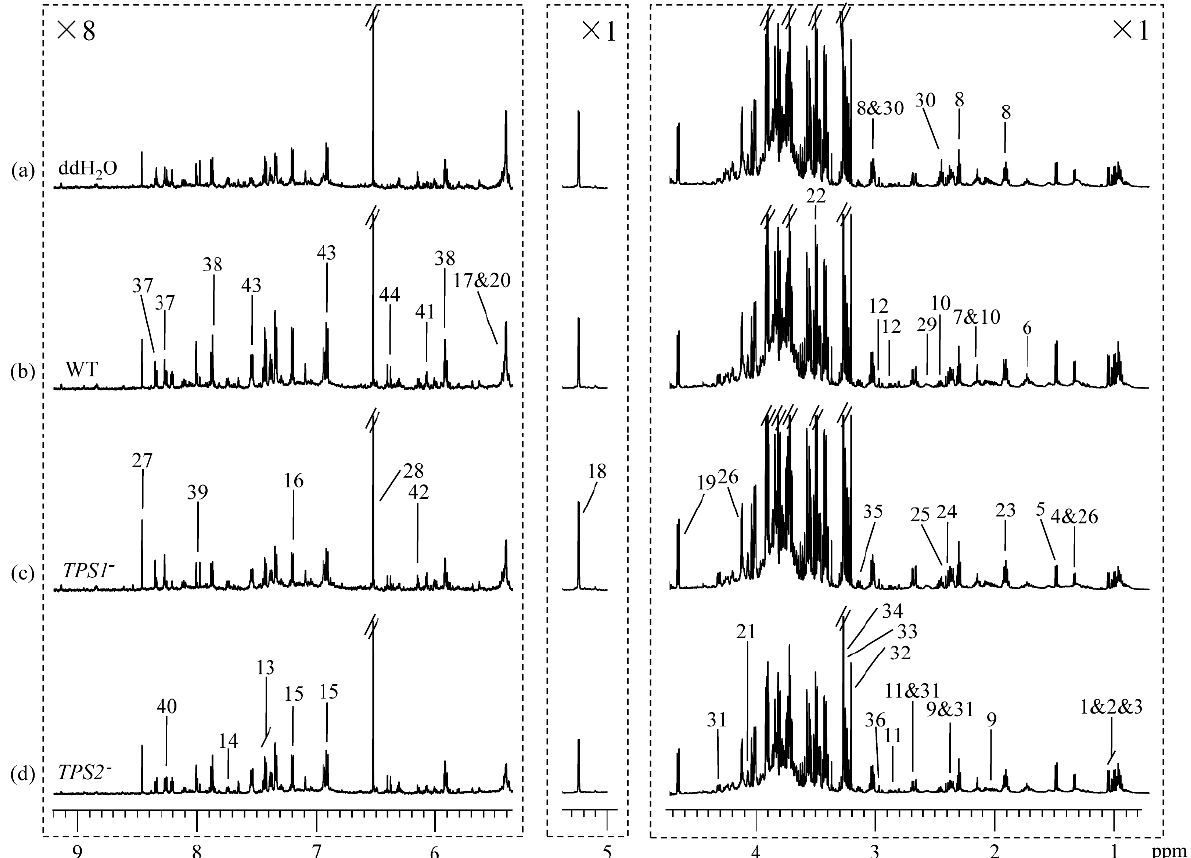
Figure 2. 1 H NMR spectra of extracts for susceptible wheat Annong 8455 inoculated with ( a ) ddH 2 O, ( b ) Fg WT 5035, ( c ) Fg TPS1 − mutant, and ( d ) Fg TPS2 − mutant for 96 h. The region δ 5.31–9.21 was vertically expanded 8 times. Keys were indicated in Figure 1 and Table S1.